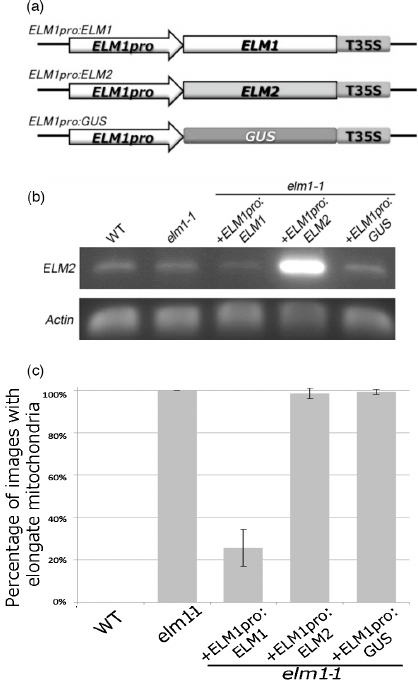
Figure 4. Heterologous complementation test of mitochondrial morphology in the elm1 mutant by expression of ELM2 . ( a ) Schematic drawing of DNA constructs used in this study. ELM1 , ELM2 and GUS coding sequences are attached between the probable promoter, the 950bp upstream region of ELM1 and the sequence of CaMV35S terminator. ( b ) RT-PCR of the full length of the ELM2 ORF in the wild-type, elm1-1 , and three elm1-1 mutants transformed with ELM1pro:ELM1 , ELM1pro:ELM2 and ELM1pro: GUS respectively. ( c ) Occurrence of elongate mitochondria in leaf epidermal cells in 14-day-old cotyledons from five Arabidopsis lines (wild-type, elm1-1 , and three elm1-1 mutants transformed with ELM1pro:ELM1 , ELM1pro:ELM2 and ELM1pro: GUS ). Occurrence is expressed as the percentage of 40 confocal laser scanning microscopic images obtained from 8 leaves from each line that were judged to have elongated mitochondria (as in the elm1-1 image in Figure 1). The experiments were repeated three times independently and the results were averaged. Error bars show S.E.